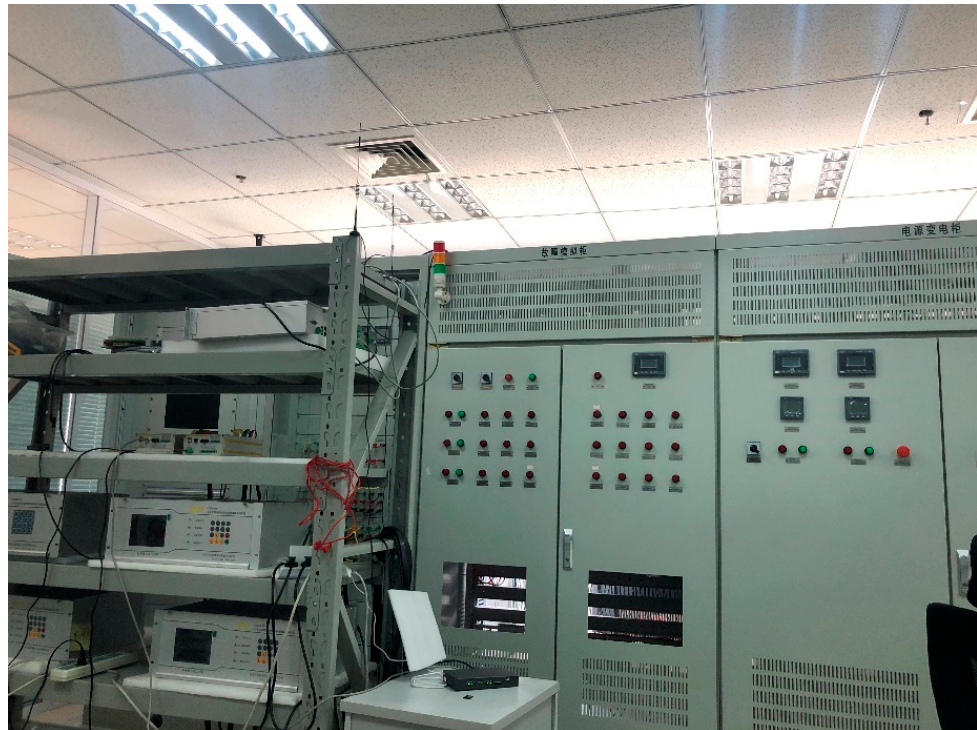
Figure 22. Dynamic simulation fault diagnosis experimental platform.